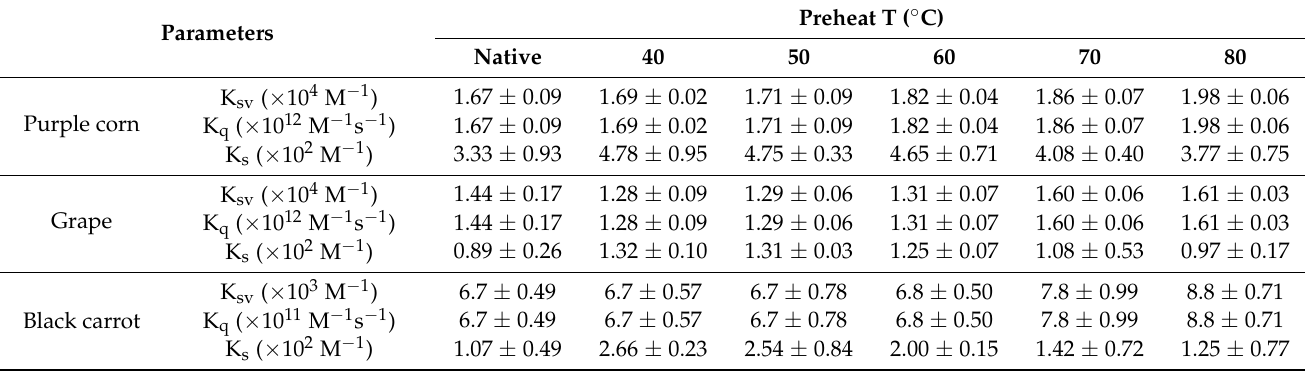
Table 2. The Stern–Volmer constants, quenching constants and binding constants for purple corn, grape and black carrot anthocyanin-rich extracts binding to native and preheated whey protein at 25 ◦ C (pH 3) at an excitation wavelength of 280